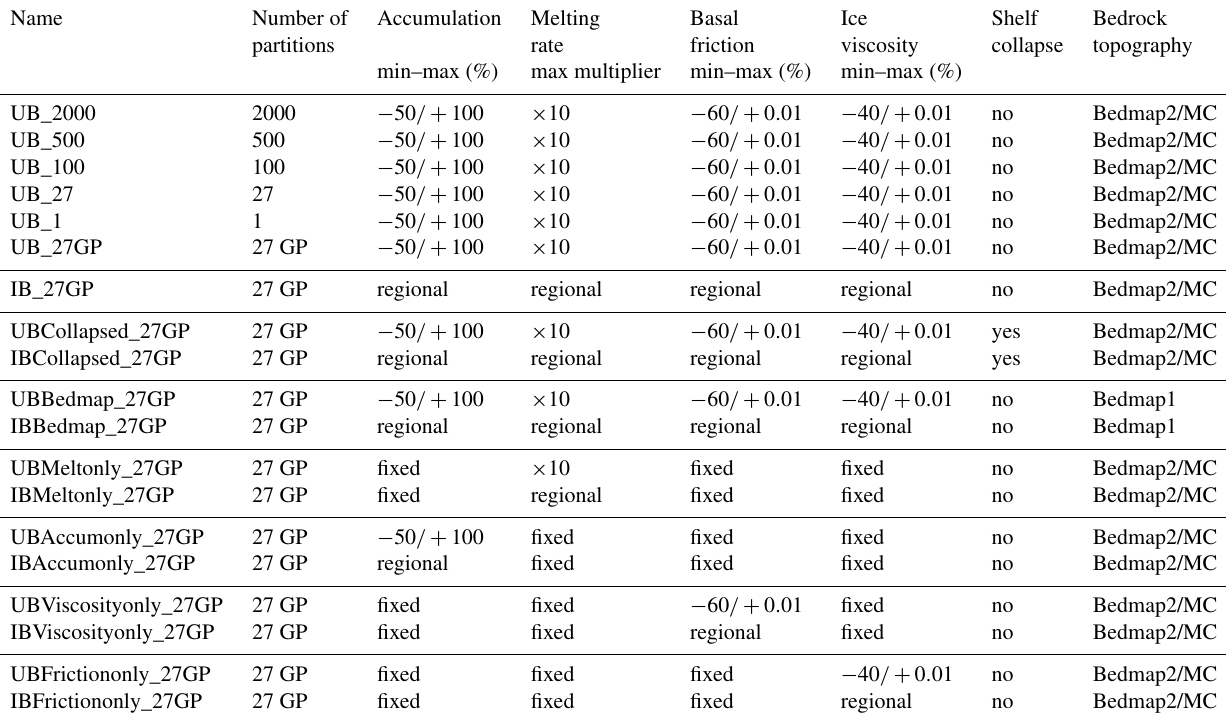
Table 1. List of sampling experiments and associated ranges of sampled variables for the UB and IB experiments. Here, we report all UB simulations. IB is marked as “regional” and is displayed in Table 2. Partitions are randomly generated, unless noted by GP, in which case they are geographically based. For ice shelf basal melt, the maximum bounds are given as melt multipliers, while all other variable bounds are given in percentage change. Minimum melt bounds within a partition are not represented here because they are not represented by a uniform value (see Table 2 and Sect.